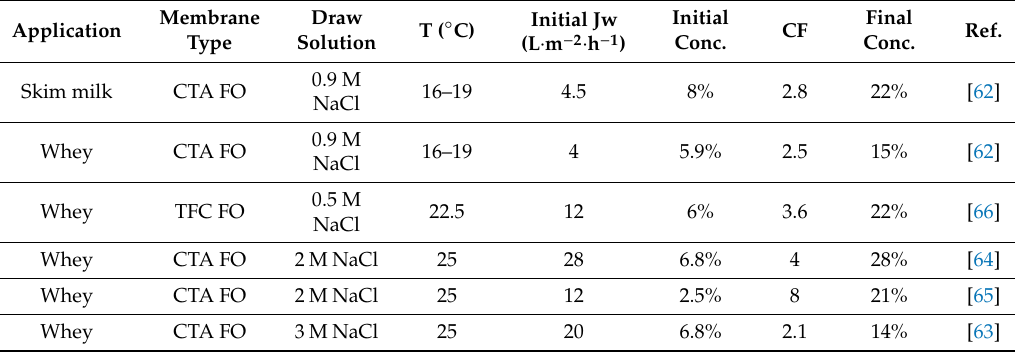
Table 3. Review of FO concentration studies for dairy